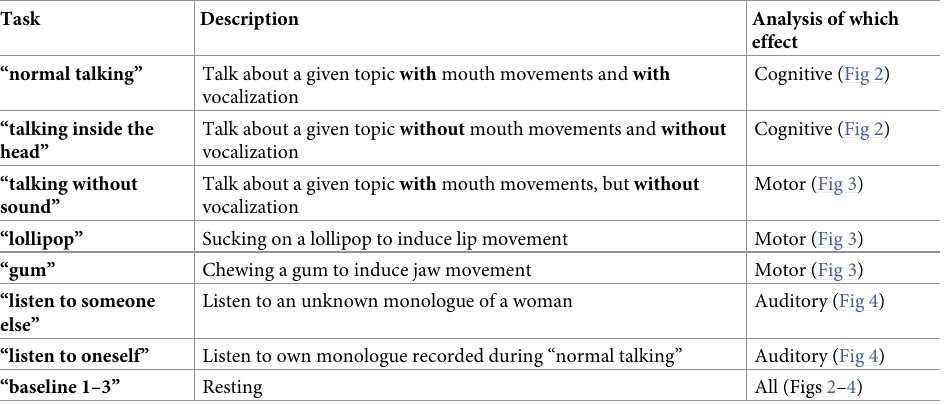
Table 1. List of tasks, their description and their use in the analysis. Task Description Analysis of which